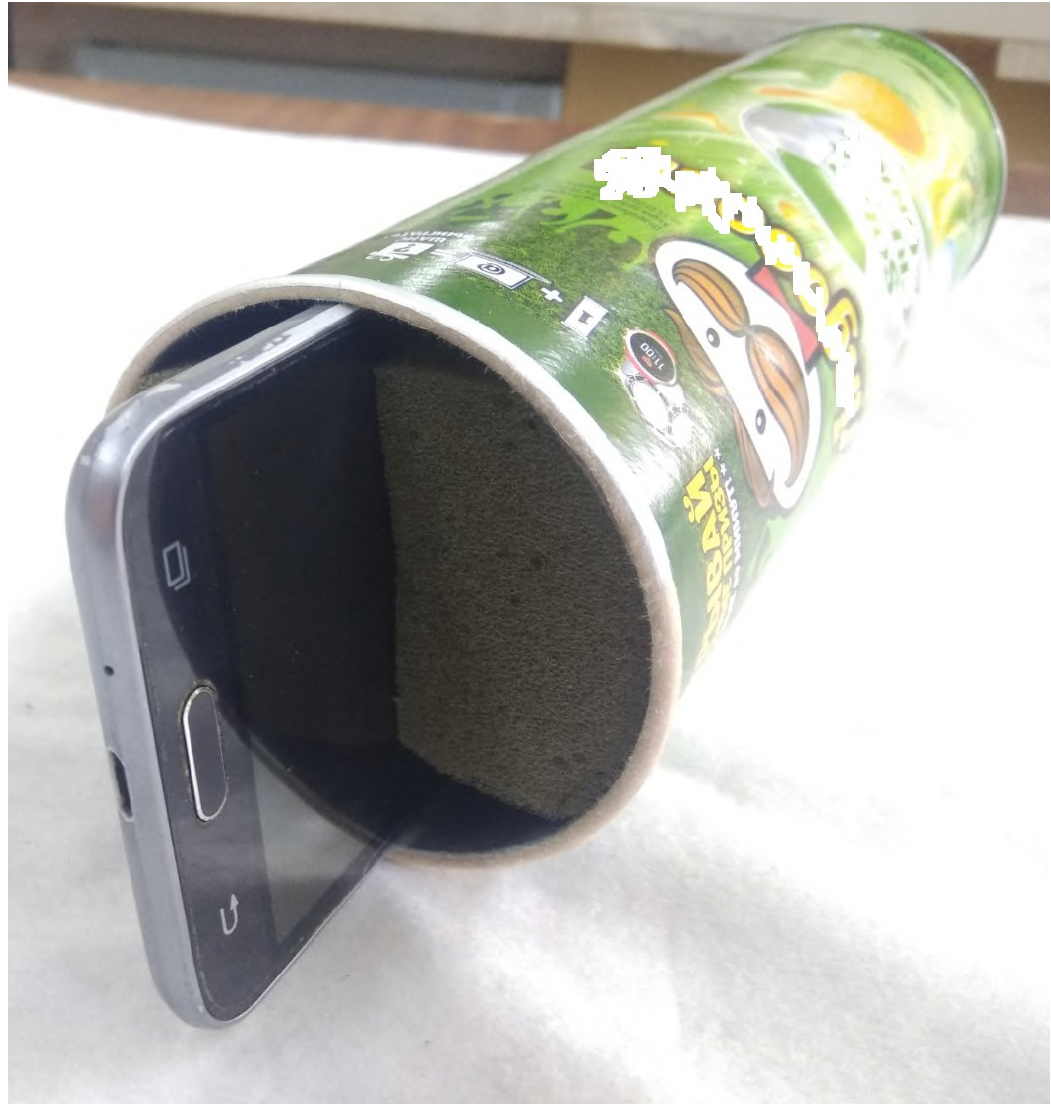
Figure 5: Smartphone mounted in a